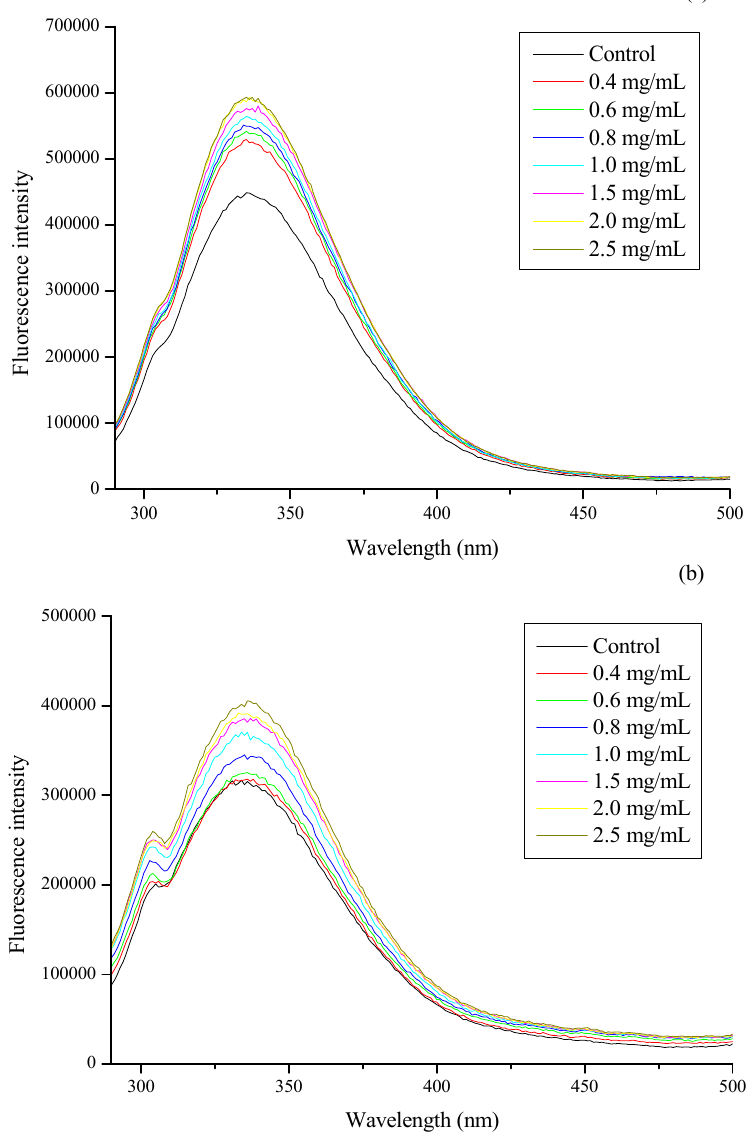
Figure 4. Effect of gradient concentration of CSNP solutions (mg/mL) and control on the fluorescence intensity of ( a ) E. coli and ( b ) S. aureus membrane proteins. The emission spectra of these samples were scanned from 290 to 500 nm when the excitation wavelength was fixed at 280 nm. The CSNPs showed strong and stable bacteriostasis during the entire experiment against E. coli. However, against S. aureus , the low-concentration CSNP (0.1 mg/mL group and 0.2 mg/mL group) solutions did not work in a short time and the concentration CSNP solution of 0.4 mg/mL did not have a long antibacterial time. This indicated that the CSNPs showed more potent antibacterial activity against Gram-negative bacteria ( E. coli ) than against Gram-positive bacteria ( S. aureus ), whereas the different mechanism led to the different effects. Although there have been numerous attempts to explain the micro- bial killing mechanism of CSNPs, it remains unclear. Some studies have reported that the interaction of the negatively charged microbial cell wall with chitosan cationic charges